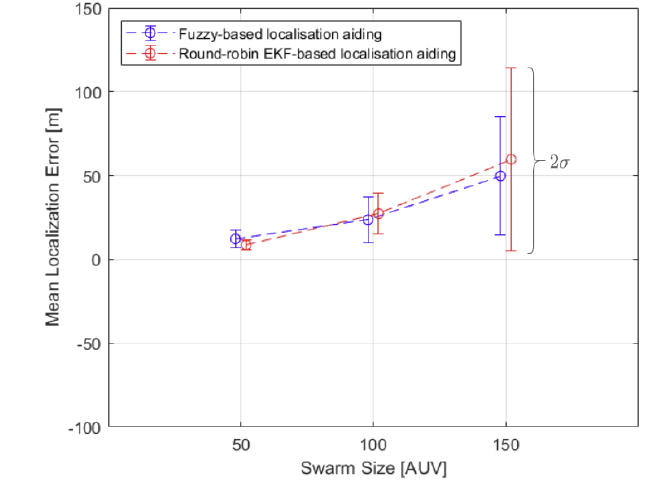
Figure 14. The entire swarm mean and standard deviation localisation error in both the proposed Fuzzy-basedUSBL/trilaterationaidedDRnavigation(inblue)andround-robinEKF-basedUSBL/trilateration aided DR navigation (in red). The error bar around the mean point represents 2 σ standard deviation.